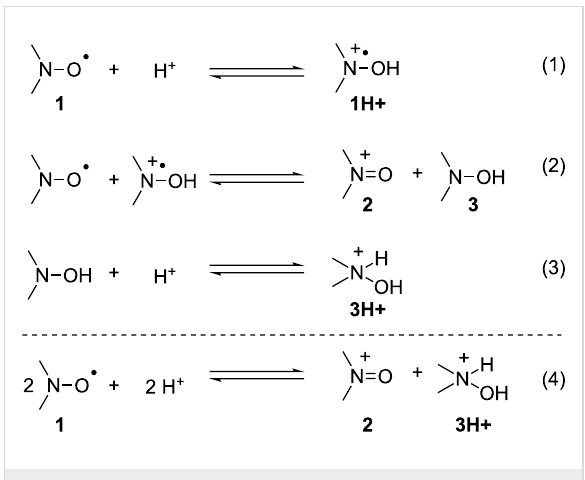
Scheme 4: Disproportionation of nitroxide 1 by acid